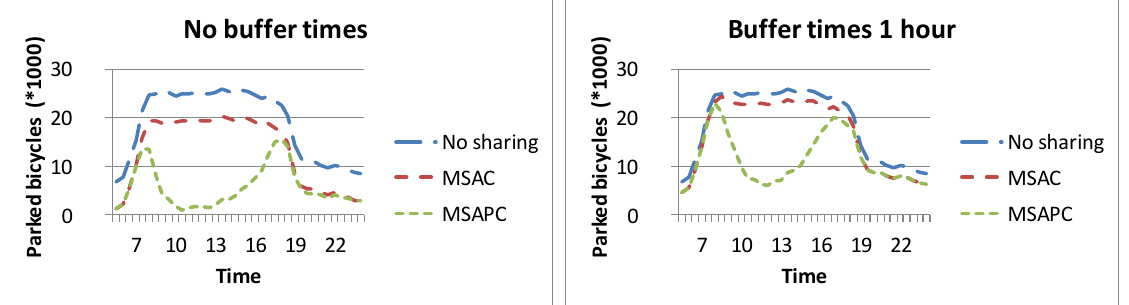
Figure 6. Distribution of parked bicycles over time for different sharing cases, central stations of the four largest cities (aggregate of individual stations)